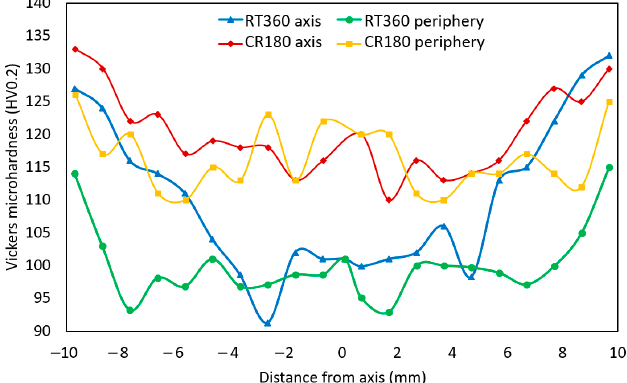
Figure 5. Vickers microhardness across deformed specimens.